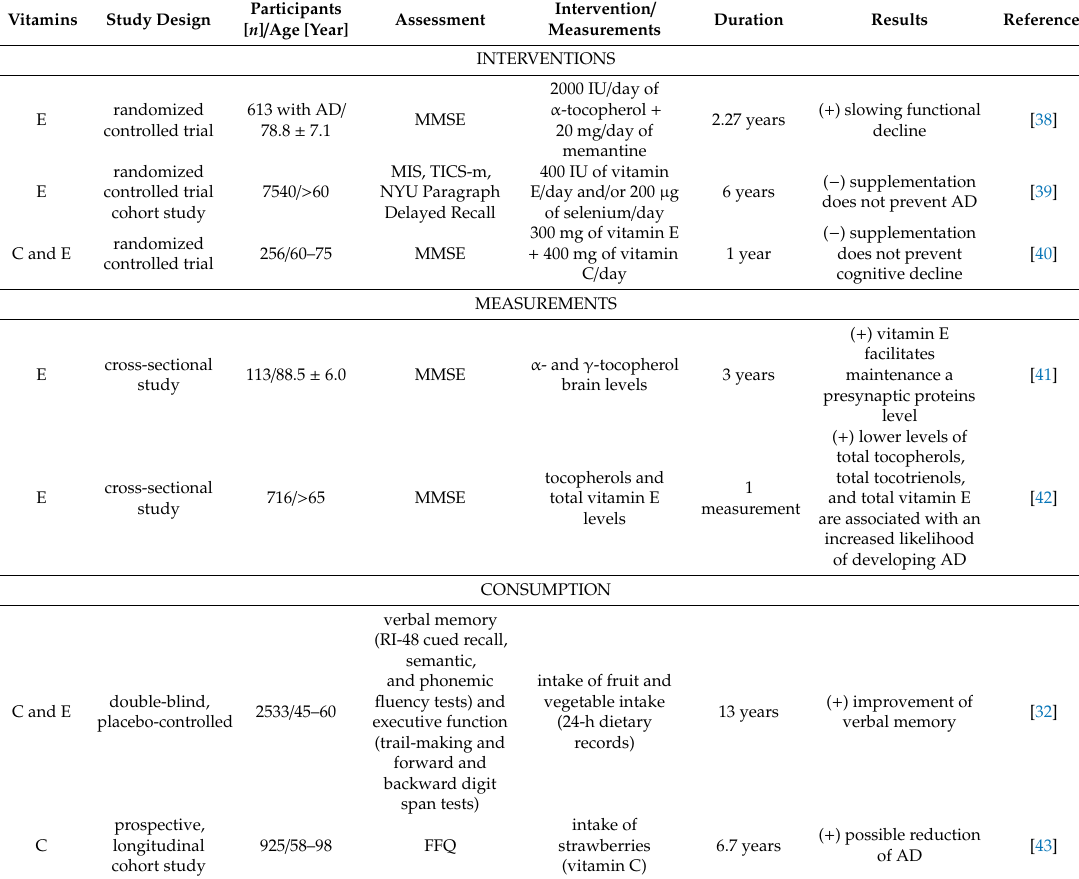
Table 4. Summary of studies on vitamin C and E consumption, supplementation, and blood measurements, and